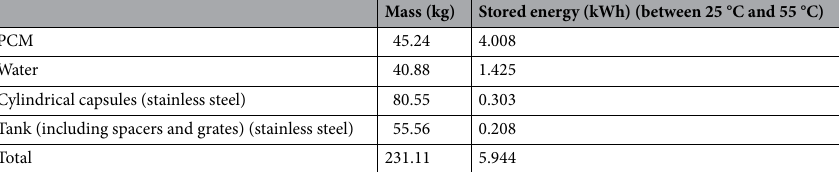
Table 1. Parameters of the experimental heat storage. Stainless steel is highly ineffective for heat storage per unit mass.